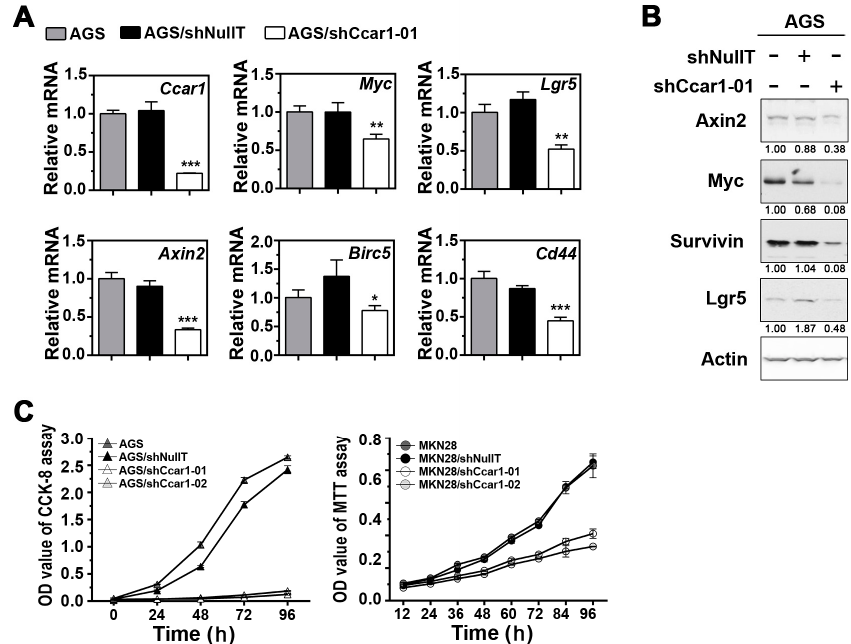
Figure 1. Cell cycle and apoptosis regulator 1 (CCAR1) knockdown affects cell growth. ( A ) The levels of the Wnt signaling downstream transcripts were quantified by real-time PCR using primers specific for the indicated genes. The results shown are normalized to the level of Actb mRNA; ( B ) Expression of Axin2, Myc, Survivin, and Lgr5 in AGS cells without infection, infected with control shRNA lentiviruses (shNullT), and infected with CCAR1-specific shRNA lentiviruses, were analyzed by western blot analysis. The density value of each band was normalized to Actin signal intensities and was expressed relative to the control (shown below each lane); ( C ) The growth curves of AGS/MKN28 cell variants with down-regulated CCAR1 were determined. The proliferation of AGS ( left ) and MKN28 ( right ) cell variants were monitored with MTT assay and their growth curves were plotted. Data are presented as the mean with error bars representing the S.D. (* p < 0.05; ** p < 0.01, *** p < 0.001).